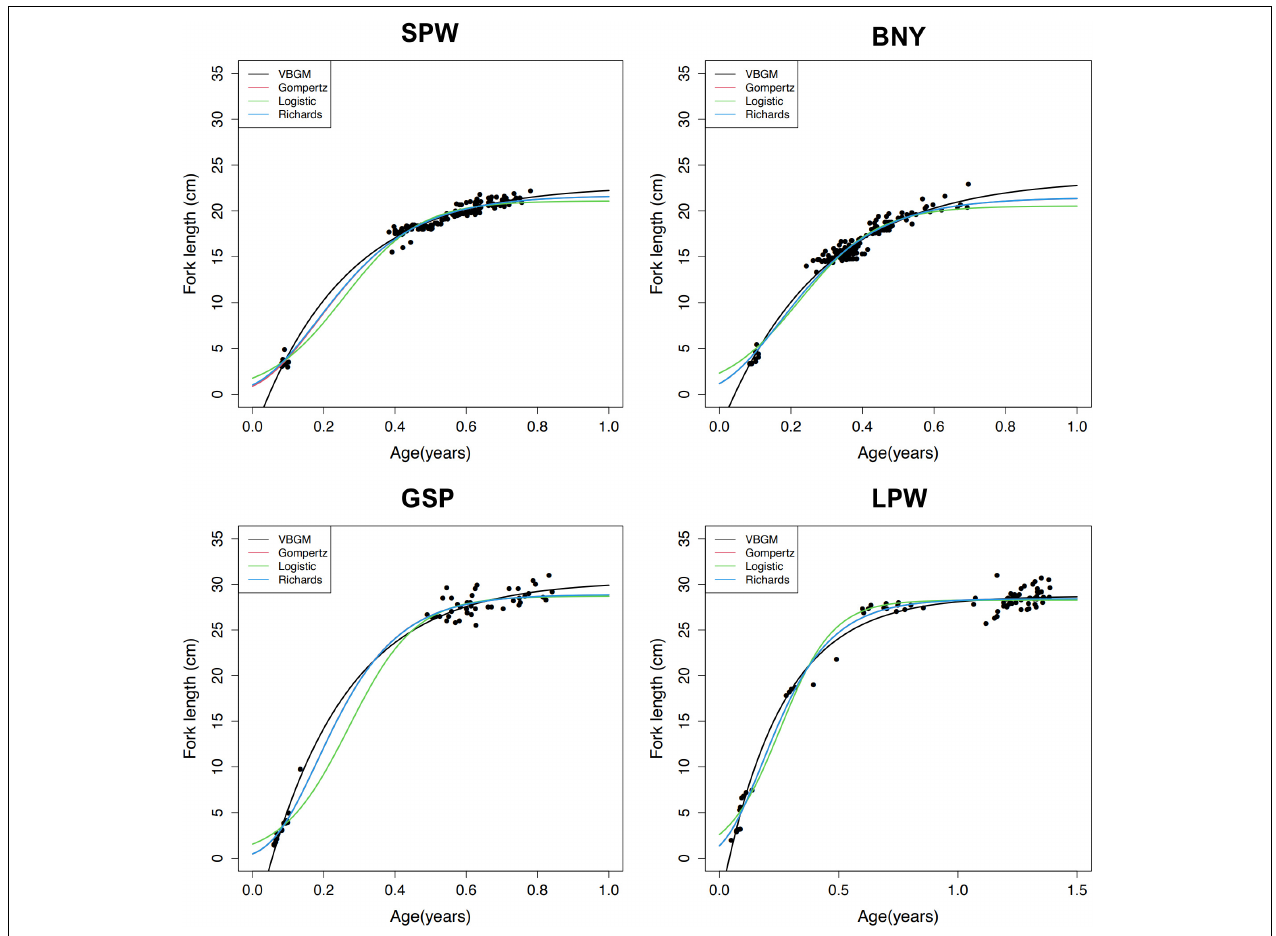
FIGURE 6 | Age and length and fitted growth curves for spotwing flyingfish (SPW), bony flyingfish (BNY), greater spotted flyingfish (GSP), and limpidwing flyingfish (LPW).